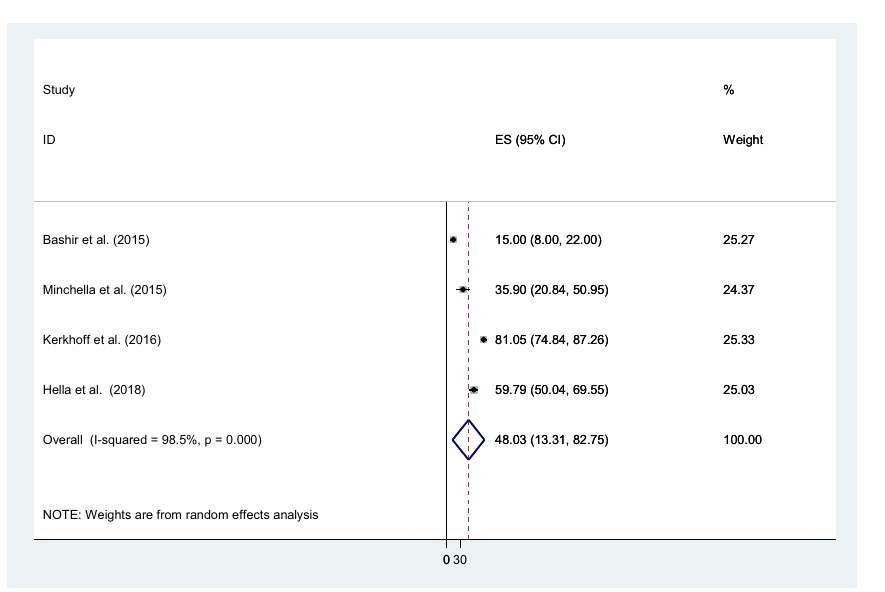
Figure 6. The pooled prevalence of anemia of chronic disease at the time of TB